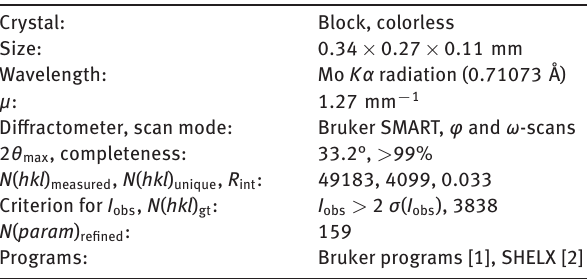
Table 1: Data collection and handling.